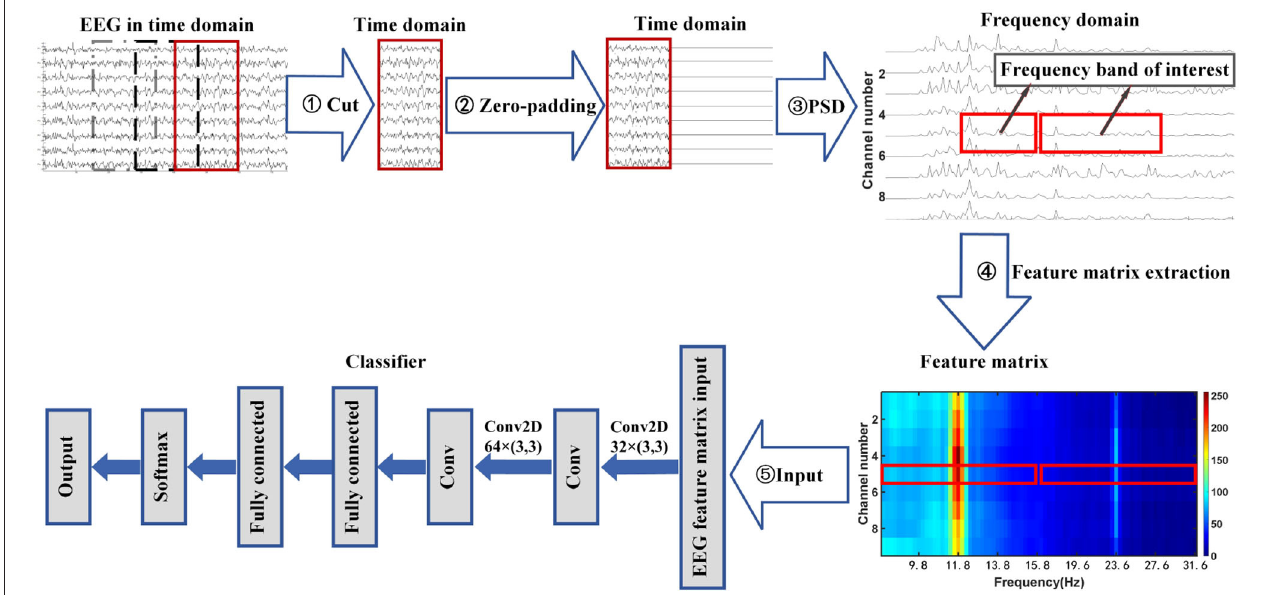
FIGURE 1 | Flowchart of zero-padding frequency domain convolutional neural network algorithm for SSVEP